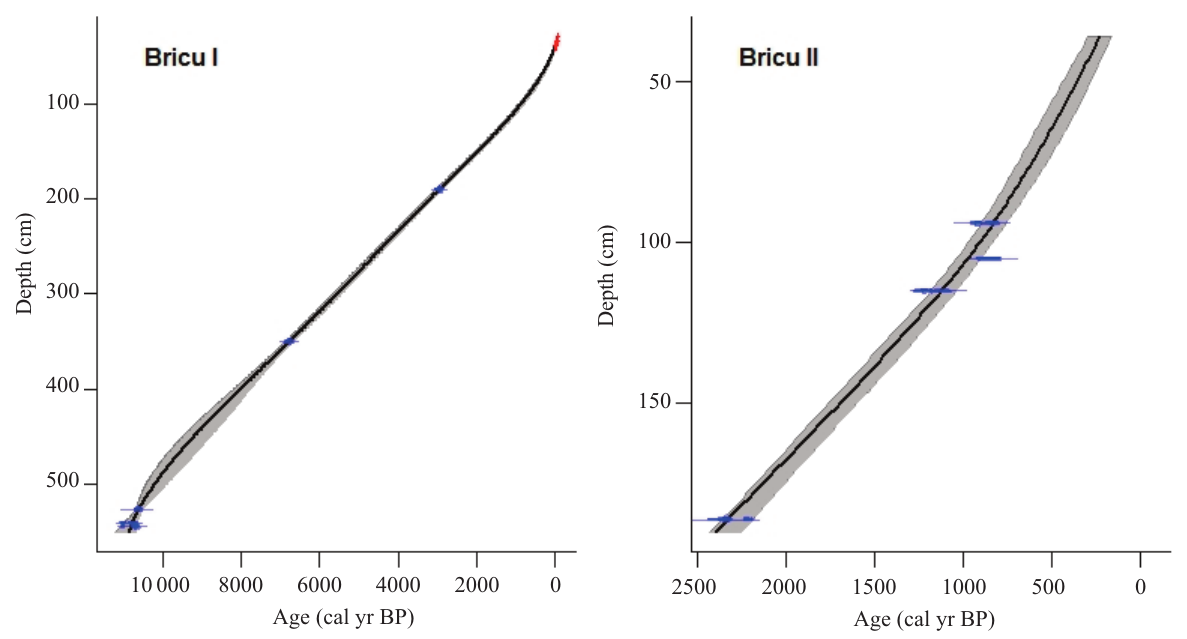
Fig. 2. Age–depth models for the sediment sequences of Lake Bricu cores I (Bricu I) and II (Bricu II) (grey area indicates a reconstructed 95% chronological uncertainty band). 14 C AMS dates are indicated in blue and spheroidal fly ash particles in